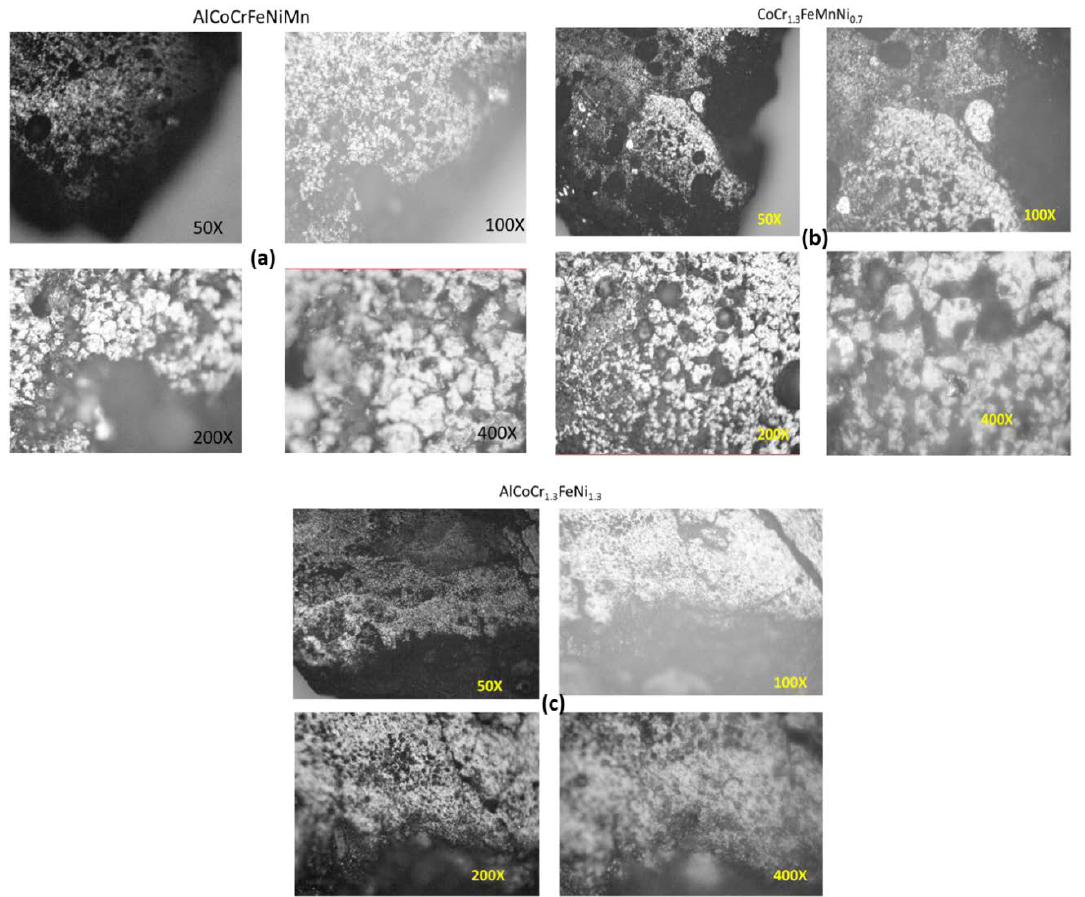
Figure A14. ( a ) The optical microscope images of alloy AlCoCrFeNiMn sample after 5 days of mass loss testing. ( b ) The optical microscope images of alloy CoCr 1.3 FeMnNi 0.7 sample after 5 days of mass loss testing. ( c ) The optical microscope images of alloy AlCoCr 1.3 FeNi 1.3 sample after 5 days of mass loss testing.